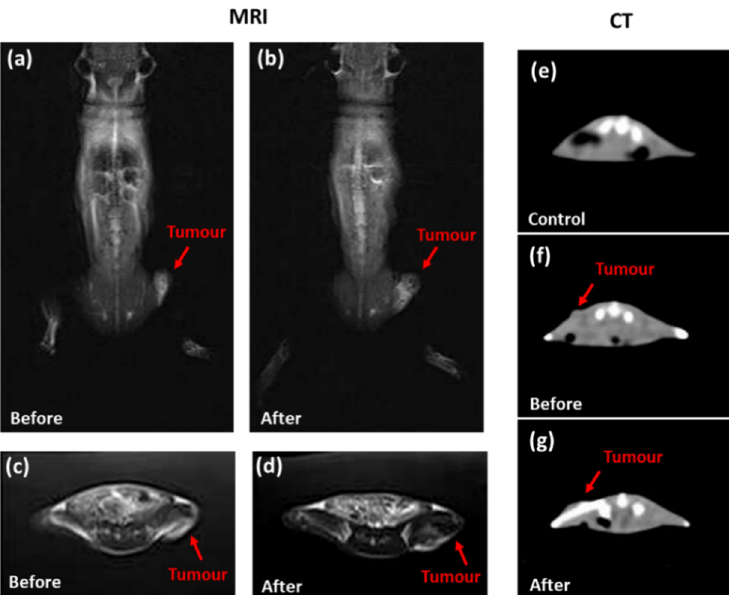
Figure 5. In vivo coronal scan T 2 -MRI images of nude mice with subcutaneous tumours ( a ) before and ( b ) after injection of Au-Fe 3 O 4 nanocomposites; in vivo cross-sectional T 2 -MRI images of nude mice with subcutaneous tumours ( c ) before and ( d ) after injection of Au-Fe 3 O 4 nanocomposites. In vivo cross-sectional CT images of ( e ) normal nude mouse, ( f ) nude mouse with subcutaneous tumour and ( g ) nude mouse with subcutaneous tumour after the injection of Au-Fe 3 O 4 nanocomposites. CT images were also acquired before and after the injection of Au-Fe 3 O 4 nanocomposites